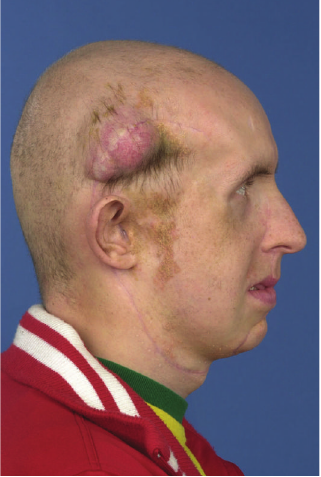
Figure 4: Subcutaneous metastasis in the scar of the craniotomy 5 months after initial treatment.